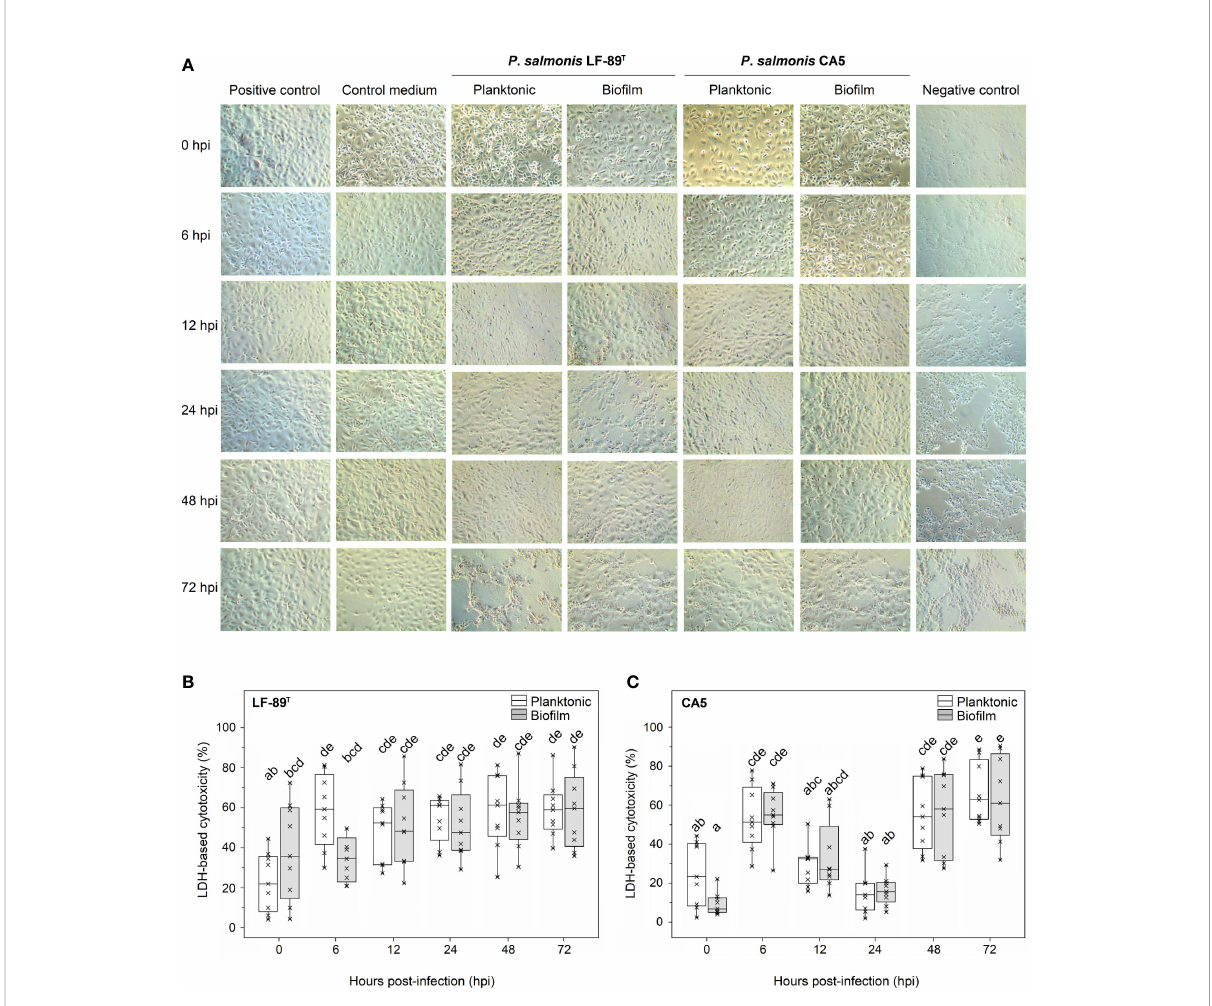
FIGURE 5 Cytotoxic effect on embryo cells from Chinook salmon (CHSE-214) induced by bio fi lm-derived and planktonic bacteria of P . salmonis . (A) Micrographs of CHSE-214 cells infected with 48-h-old bio fi lm-derived bacteria or planktonic counterparts. The cytotoxic effect was measured as the lactate dehydrogenase (LDH) release from CHSE-214 cells infected with P . salmonis (B) LF-89 T and (C) CA5. Box plots show the median of data sets (×), upper/lower quartiles (boxes), and range of percentages (vertical lines). Statistically signi fi cant differences between boxes (Tukey HSD test; P < 0.05) are depicted with different letters. Data were taken from three independent